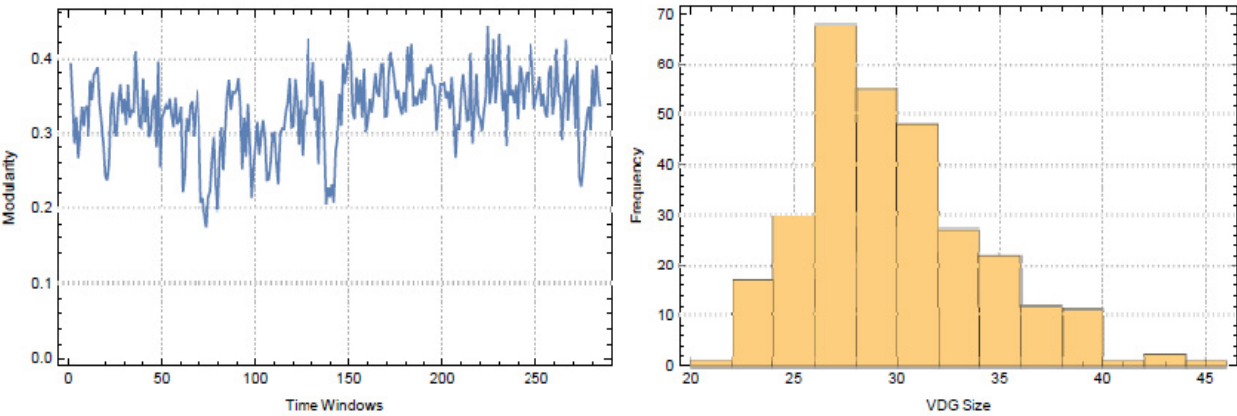
Figure 3. 𝒬 (cid:3037) measures and sizes of coarse graining of 𝐺 (cid:3021)(cid:3037) for FTSE100. Figure 3. Q j measures and sizes of coarse graining of G